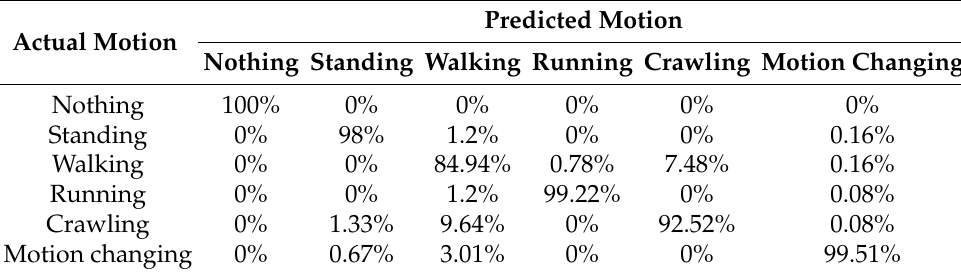
Table 3. Classification results from the CNN-based classifier (Case 2).